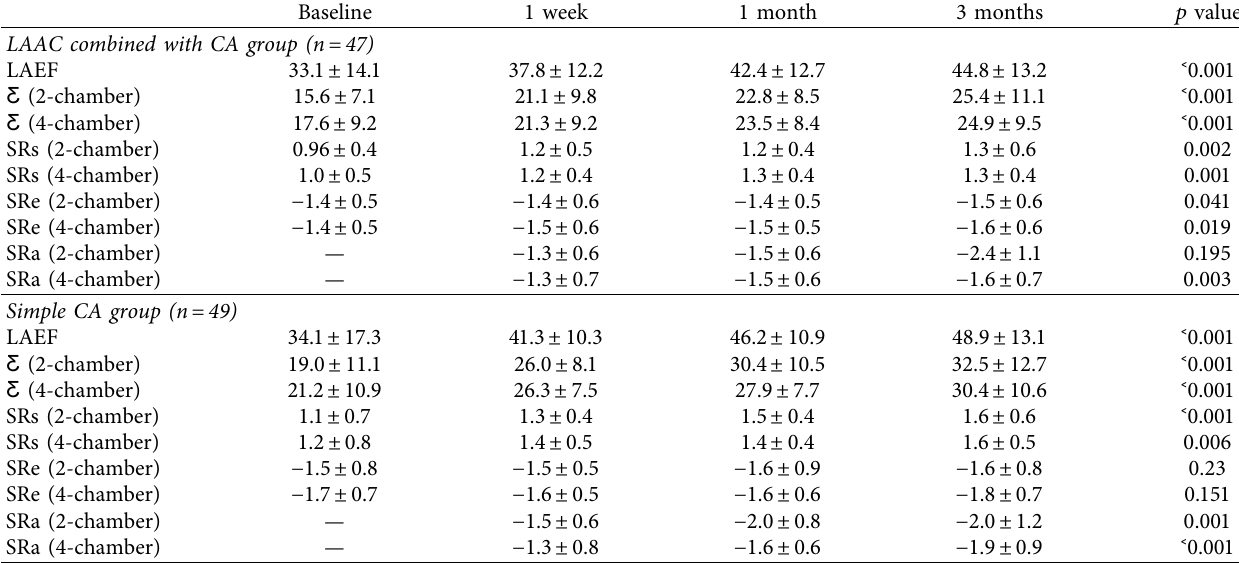
Table 2: Changes of mechanical cardiac functions after the combined procedure and simple catheter